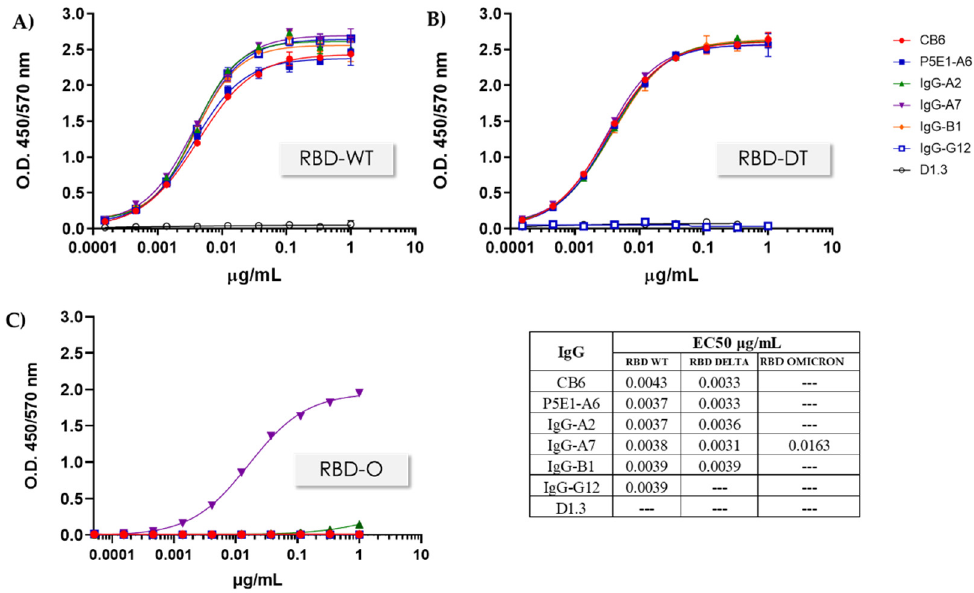
Figure 4. RBD:IgG binding assay. Binding activity to RBD-WT, RBD-DT and RBD-O was assessed for representative IgGs in a concentration interval of 0.0001–1 µg/mL. ( A ) Binding to RBD-WT, ( B ) Binding to RBD-DT and ( C ) Binding to RBD-O. The data were fit to a four-parameter dose–response in GraphPad Prism 9.3.1. and the the EC 50 values were calculated.